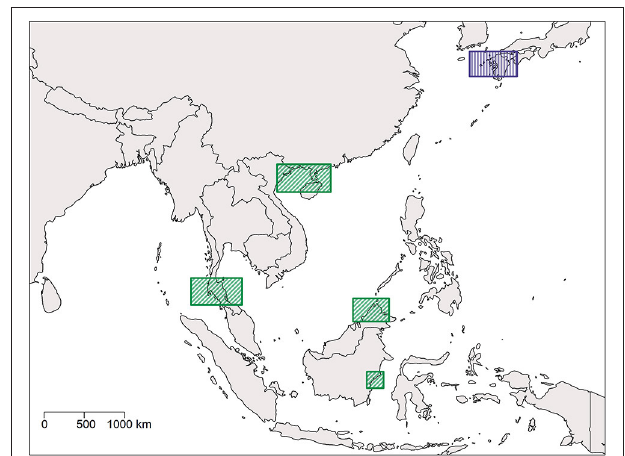
FIGURE 6 | Map of Southeast Asia and Japan showing regions which are optimal for the establishment of MPAs in order to conserve the three Asian species of horseshoe crabs. Rectangles with diagonal lines and green color indicate areas where MPAs for horseshoe crab conservation are absent, whereas rectangles with vertical lines and purple color indicate areas where MPAs for horseshoe crab conservation are already